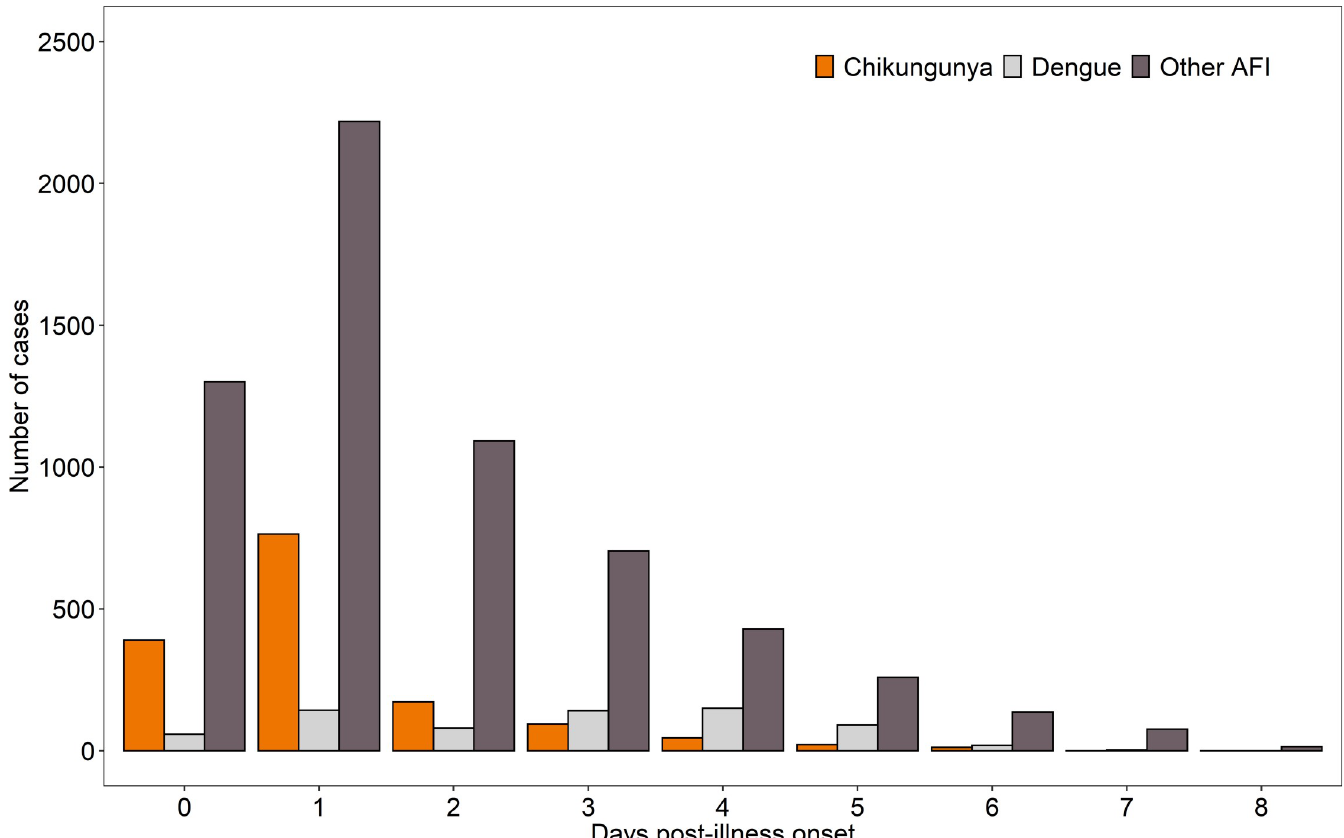
Fig 2. Timing of presentation for laboratory-confirmed chikungunya cases versus all other acute febrile illness cases and dengue cases.